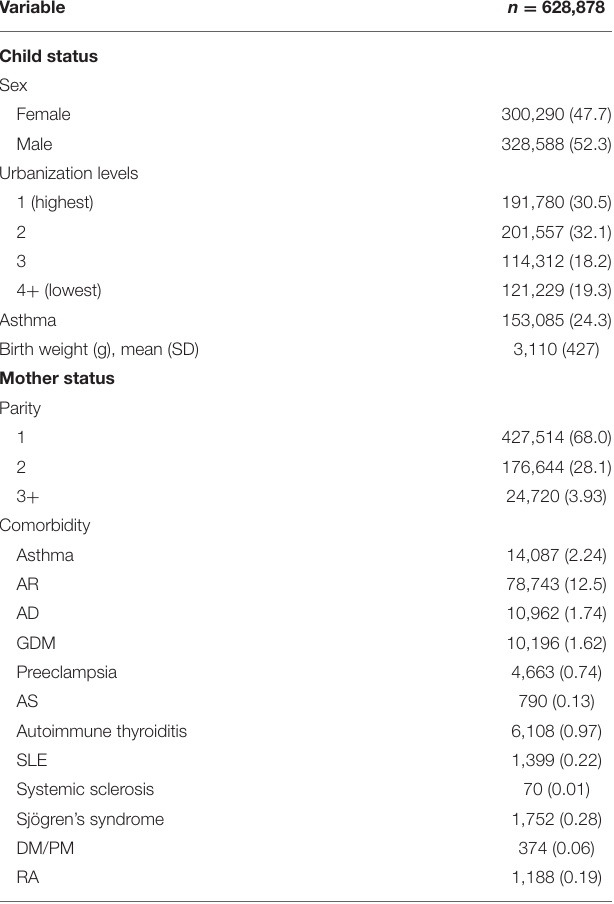
TABLE 1 | Demographic data of study